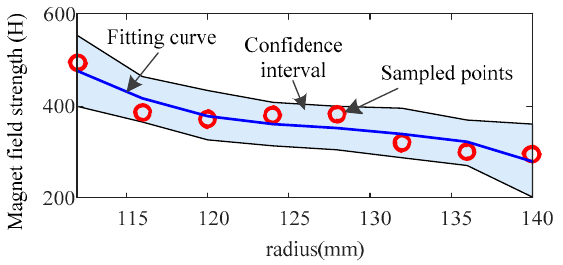
Figure 19. Fitting curve and its confidence interval of different radius.